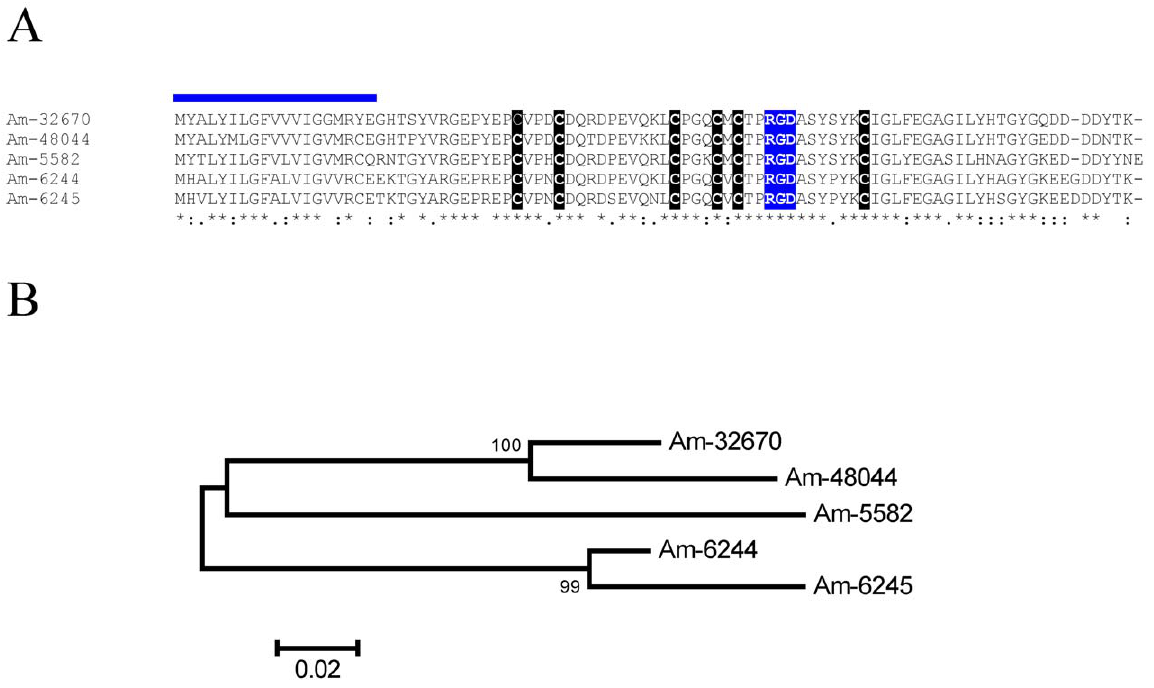
Figure 6. The salivary disintegrins 40–270 family of Amblyomma maculatum . ( A ) Alignment indicating conserved cysteines in black background, RGD motif in blue background, and blue bar above the sequences indicating the signal peptide indicative of secretion. The symbols at the bottom indicate (*) identity of residues, (:) conserved, and (.) less conserved residues. ( B ) Bootstrapped phylogram of the alignment in ( A ). The numbers at the nodes indicate the bootstrap support, and the bar at the bottom indicates 2% amino acid divergence.